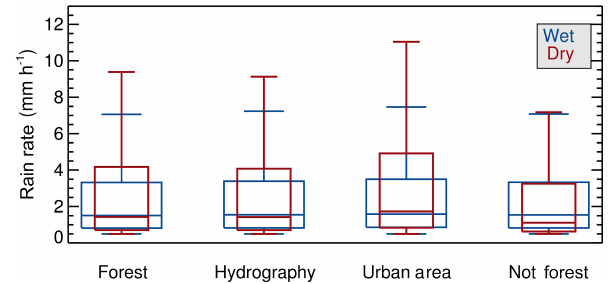
Figure 9. Rainfall rate (RR; from S-band radar) box plots for the wet and dry seasons given different surface cover classes. Each box represents the 25 to 75% populations, and the line inside the box represents the median